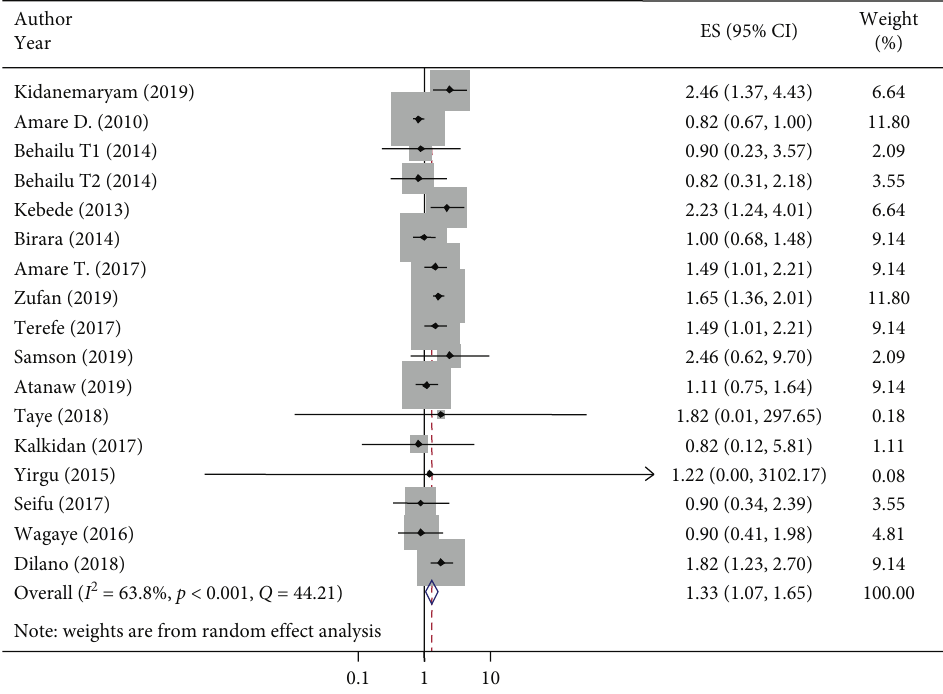
Figure 4: Association of medium household wealth index with stunting among children under five years of age and its 95% CI in Ethiopia, 2010–2019.